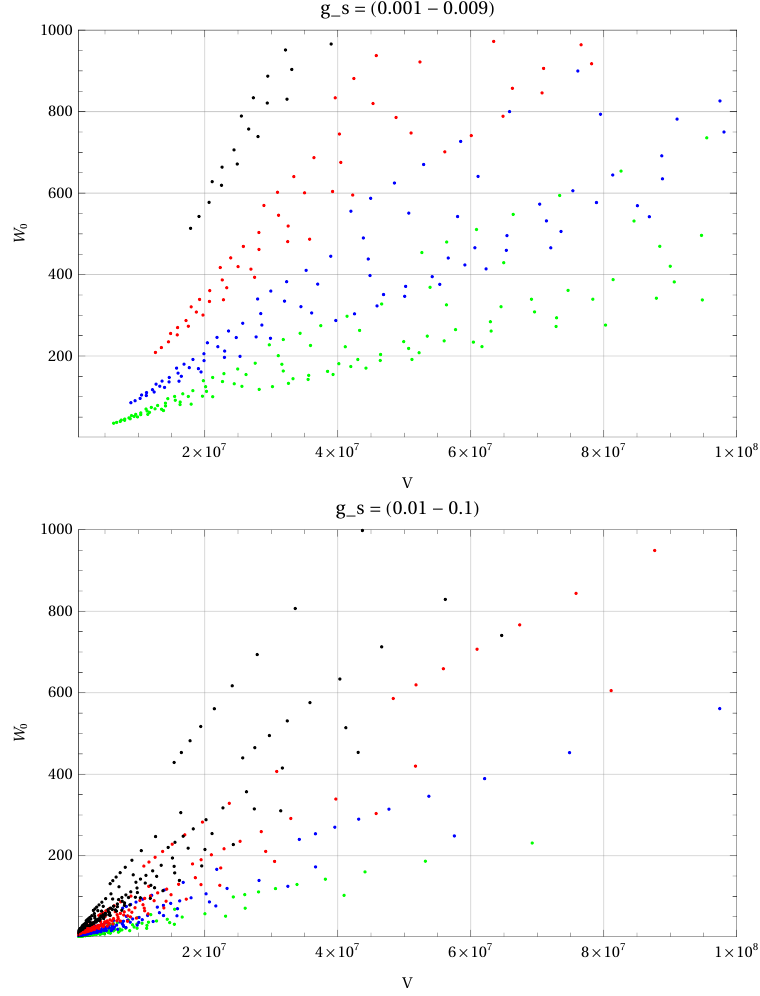
Figure 2 . Selected data points for different values of g s and λ . Around 29% of the data points are in the lower g regime, while around 71% are in the upper regime. Black points correspond to s λ = 10 4 , red to λ = 10 3 , blue to λ = 10 2 , and green to λ = 10 .